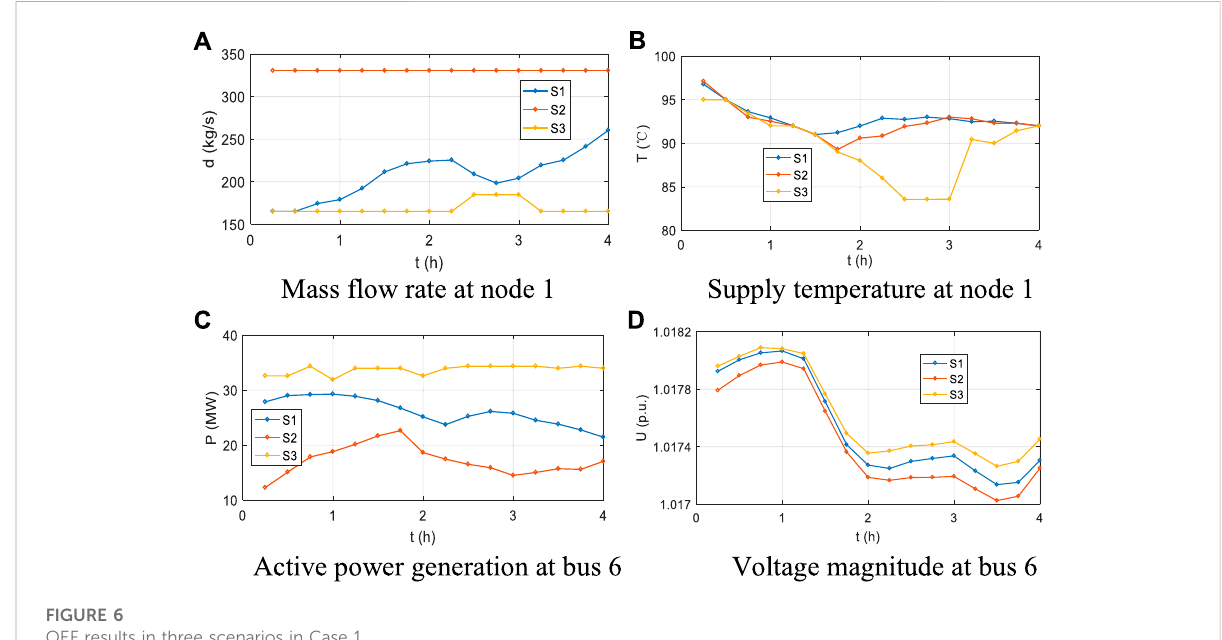
FIGURE 6 OEF results in three scenarios in Case 1.